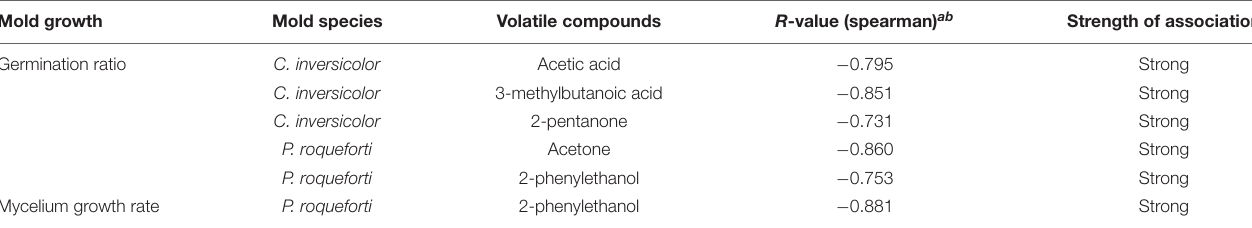
TABLE 4 | Spearman’s correlation coefficient analysis between germination ratio (%)/mycelium growth rate ( µ /h) and the VOCs detected in the cell-free supernatants of D. hansenii strains. Mold growth Mold species Germination